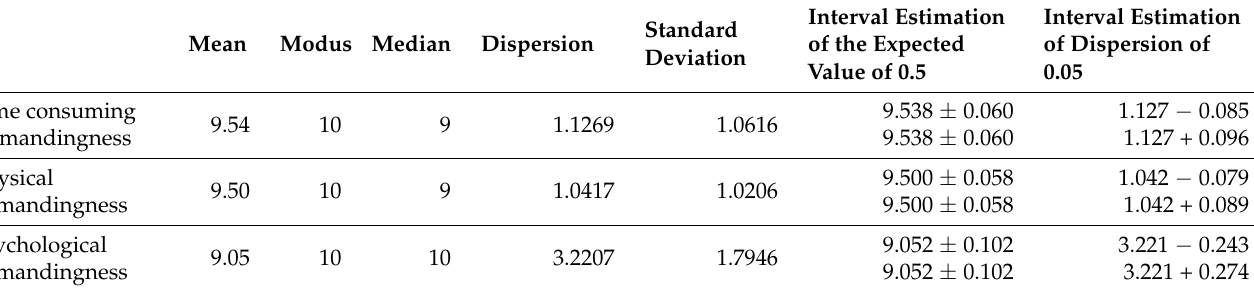
Table 3. Subjective feelings regarding demandingness (on a 0–10 scale).